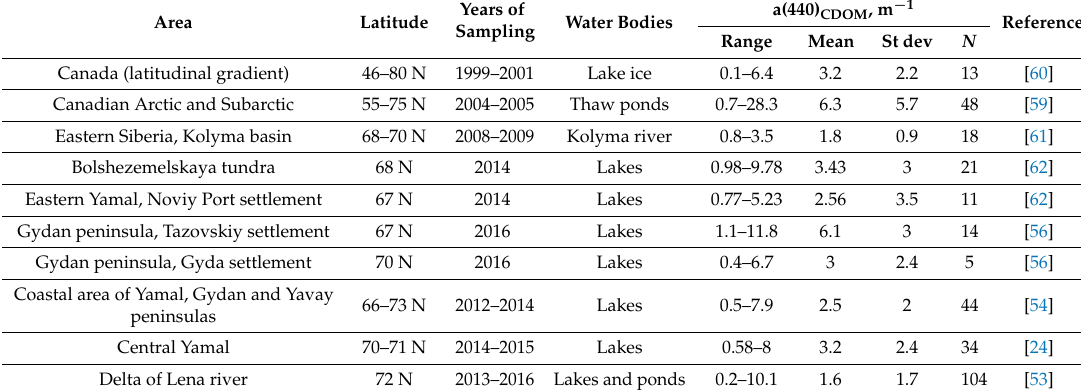
Table 5. CDOM absorption in Arctic lakes and water bodies found in the literature. In some cases the CDOM absorption results were given in other than 440 nm and we applied the equation 1 [36] to retrieve the absorption values for the needed wave length 440 nm: a(440) CDOM = a ( λ g) CDOM × exp[ − S(440 − λ g), where a( λ g)CDOM is a CDOM absorption at given in the literature wavelength; S was considered equal to 0.015 nm − 1 as often measured in both fresh waters and marine saline waters ([27] and references